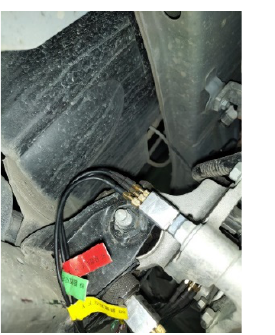
Fig. 11. The Acoustic sensors at power cabin.